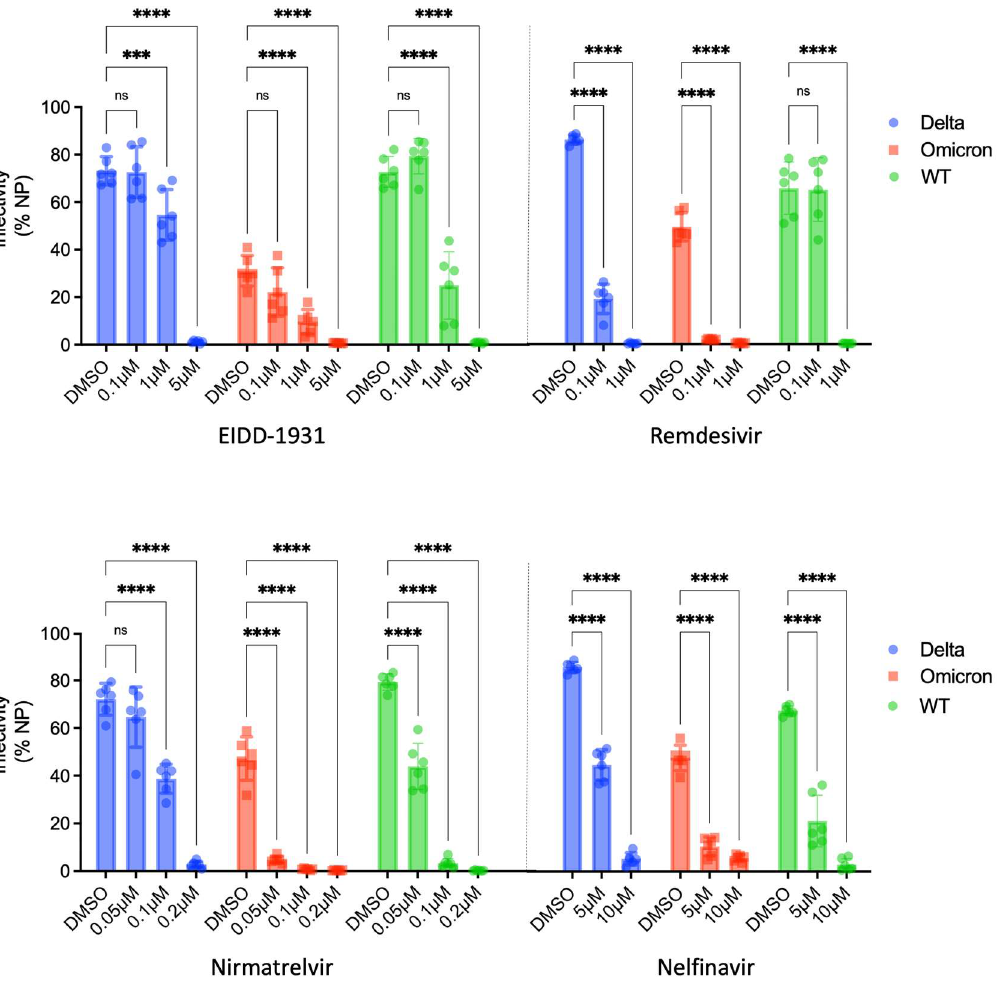
Figure 5. The antiviral activity of EIDD-1931, remdesivir, nirmatrelvir, and nelfinavir against wild- type, delta, and omicron SARS-CoV-2 infection in ACE2plusC3 cells. Small molecules were evaluated in ACE2plusC3 cells at the indicated concentrations ( µ M) or with DMSO control. Cells were infected with wild-type SARS-CoV-2 and the indicated variants at an MOI of 0.1 for 48 h. Virus-infected cells were visualized with immunofluorescence staining of SARS-CoV-2 NP. Infectivity was measured as described in Figure 1. Each concentration was performed in sextuplicate with averages and standard deviations indicated. ns, not significant; ***, p < 0.001; ****, p < 0.0001.